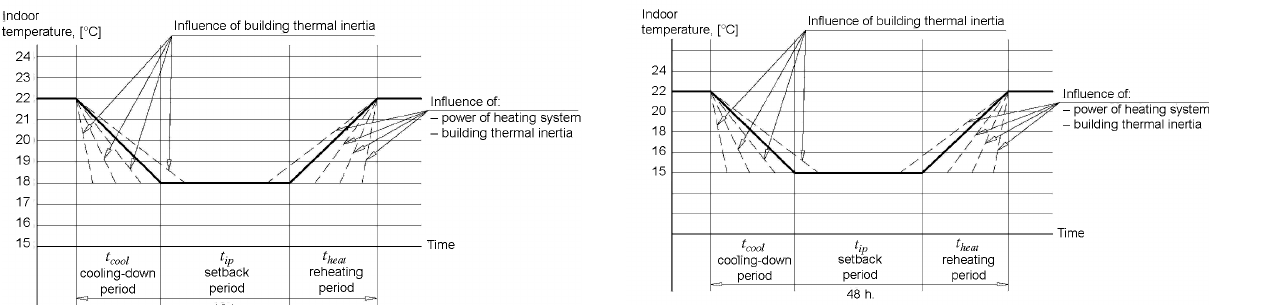
Fig. 7. Phases of intermitted heating, during the 12 h of daily temperature reduced period